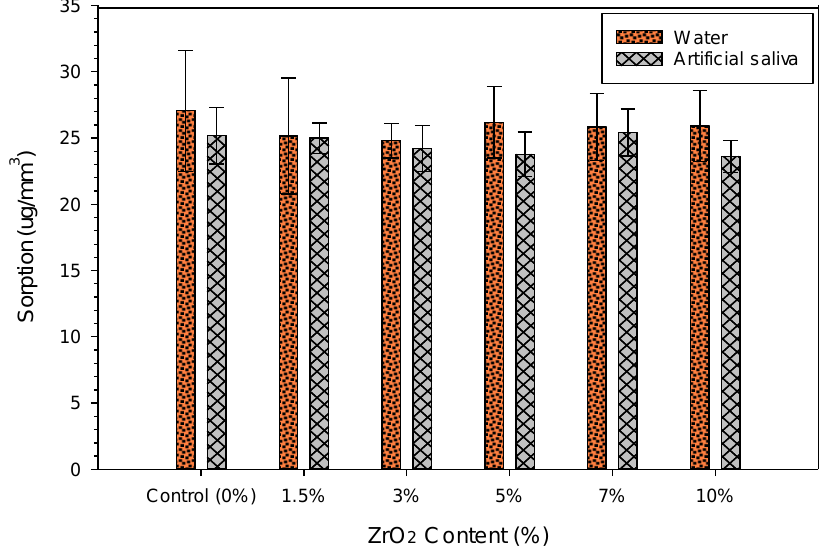
Figure 3. Bar chart demonstrating the mean solubility values of specimens after immersing for 180 days in distilled water and artificial saliva.